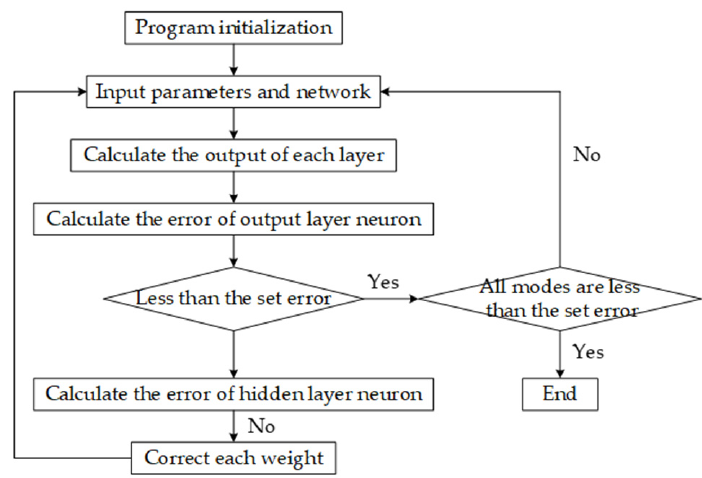
Figure 4. Flow chart of learning process.